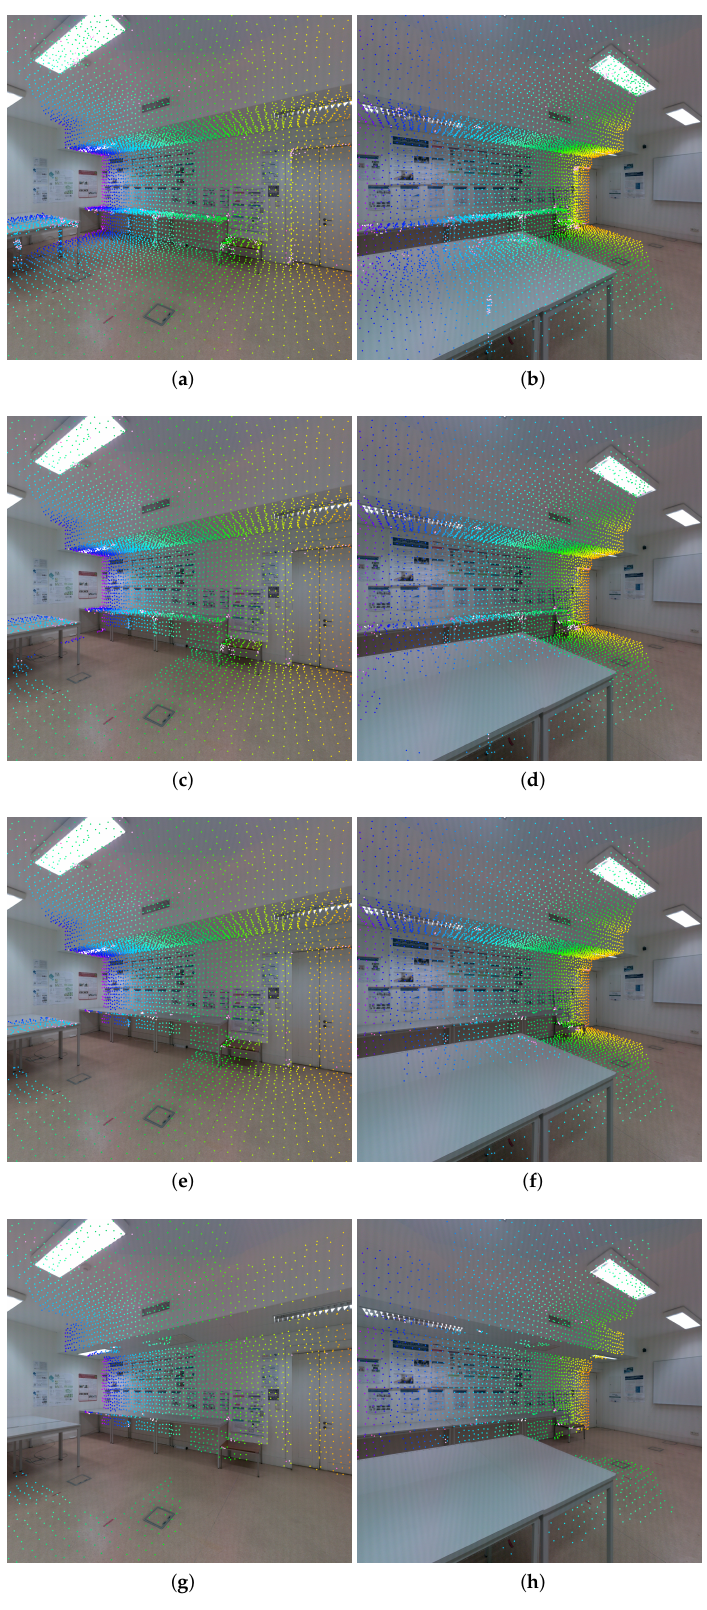
Figure 3. Pairwise mappings filtering procedure: ( a , b ) pairwise mappings with no filter applied; ( c , d ) pairwise mappings with z-buffering applied; ( e , f ) pairwise mappings with z-buffering filter and depth consistency applied; and ( g , h ) pairwise mappings with the entire filtering procedure